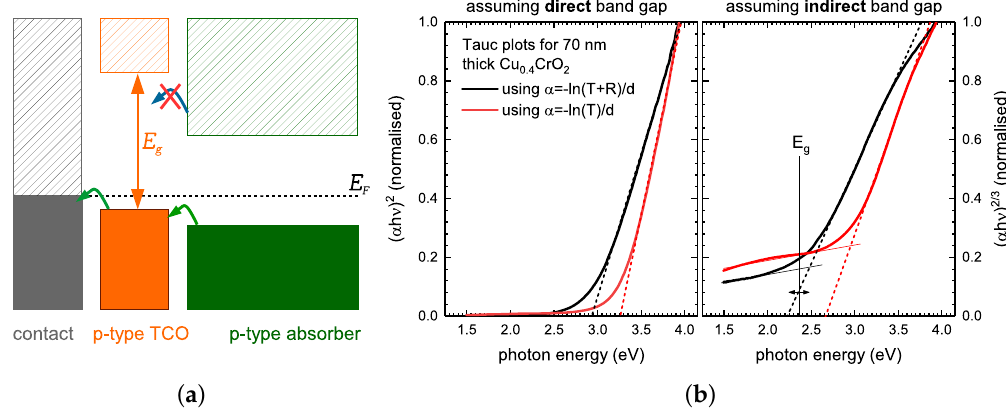
Figure 3. ( a ) Schematic illustration of the preferred band alignment for a hole transport/electron blocking layer; ( b ) Tauc plots for a 70nm-thick Cu 0.4 CrO 2 thin film using both transmission and reflection data (black lines) as well as transmission data only (red lines). The Tauc plot for both an assumed direct and an indirect band gap are shown. Only by ab initio information predicting an indirect band gap can the actual band gap of the material be correctly